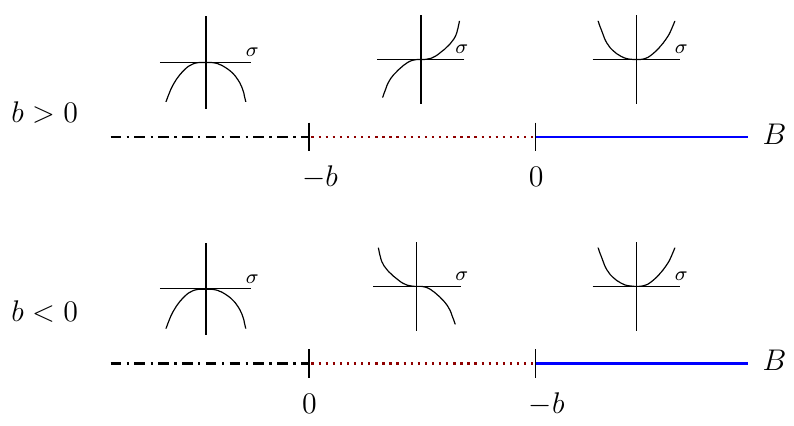
Figure 23 . Plots of the potential U eff ( σ ) at C = 0 and at different values of the parameter B (the x -axis of the figure). The blue solid line indicates that the potential has a minimum at σ = 0 , the red dotted line indicates that it has a point of inflection and the black dashed-dotted line indicates that it has a